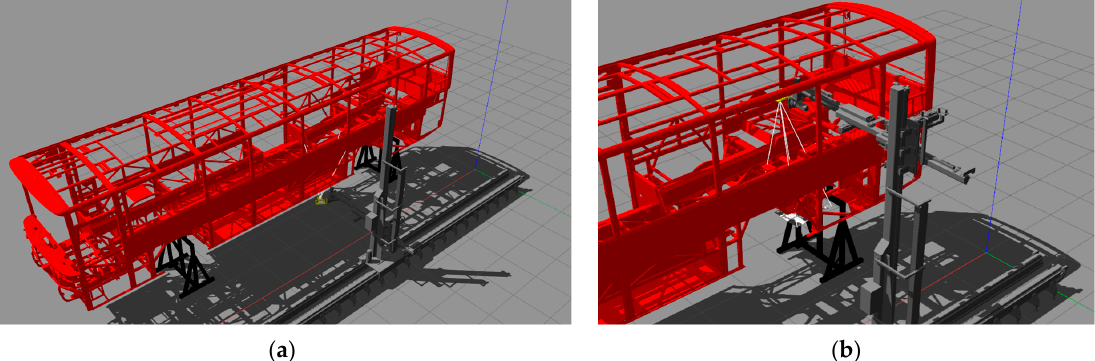
Figure 3. SRVT simulation environment. ( a ) A general perspective. ( b ) A close scene for robotic arm.